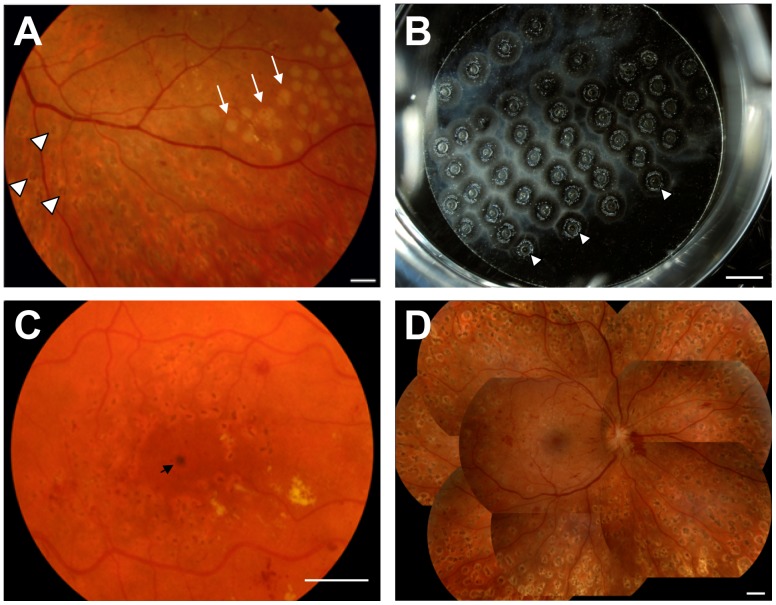
In vivo and in vitro photocoagulation.Representative images showing: A) Pale dots (white arrows) in the upper right portion of the field observed shortly after exposure to the laser (spot size = 500 µm). The image was acquired during a second session of pan-retinal photocoagulation 10 minutes after laser exposure in a patient with proliferative diabetic retinopathy. The darker pigmented dots (arrowheads) observed in the lower part of the field are the result of a previous photocoagulation session 13 days earlier. B) Lesions observed minutes after in vitro photocoagulation of ARPE-19 cells cultured on glass cover slips (spot size = 200 µm). Images were obtained using a Nikon D2X digital camera. Small gas bubbles appear between the paper and the glass cover slip after photocoagulation, forming the pale punctuated rings observed around the lesions. Small bubbles often merge into bigger central bubbles (white arrowheads). C) Pigmentation after grid photocoagulation in a patient with diabetic macular oedema. D) Pigmentation after pan-retinal photocoagulation in a patient with proliferative diabetic retinopathy. Scale bars represent 1500 µm.